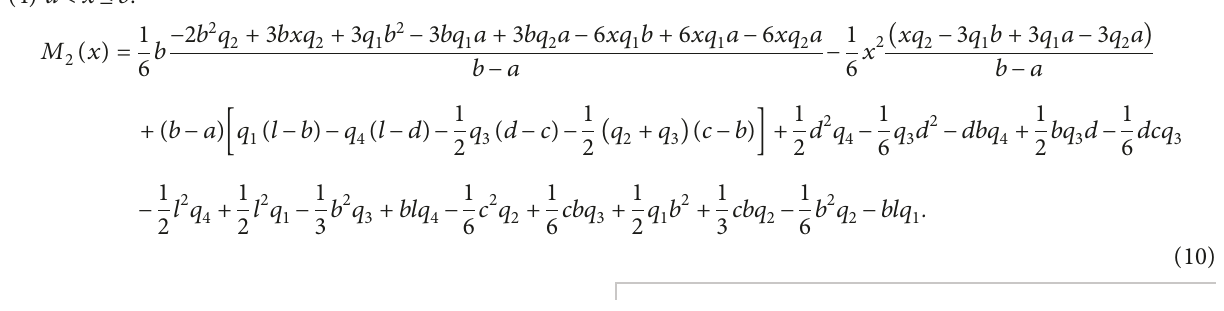
and the elastic modulus 2.2 GPa of the Mentai Buliangou coal measured in laboratory into equations (7)–(11), we get the bending moments of segments, which are put into equation (1) for the angles and deflections of segments, shown in equations